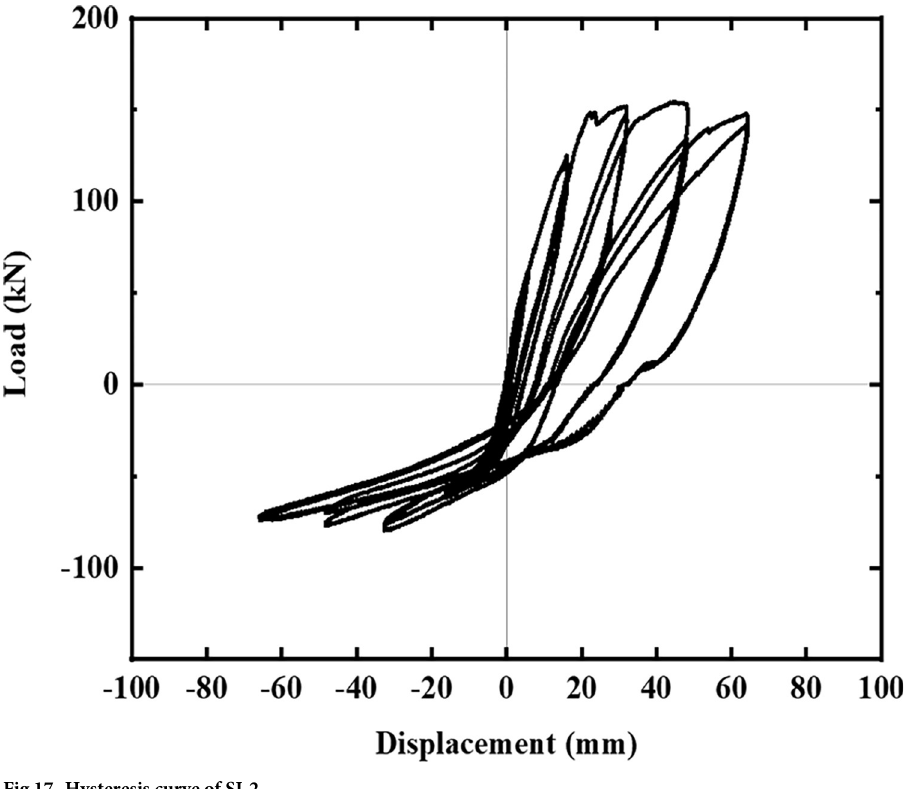
Fig 17. Hysteresis curve of